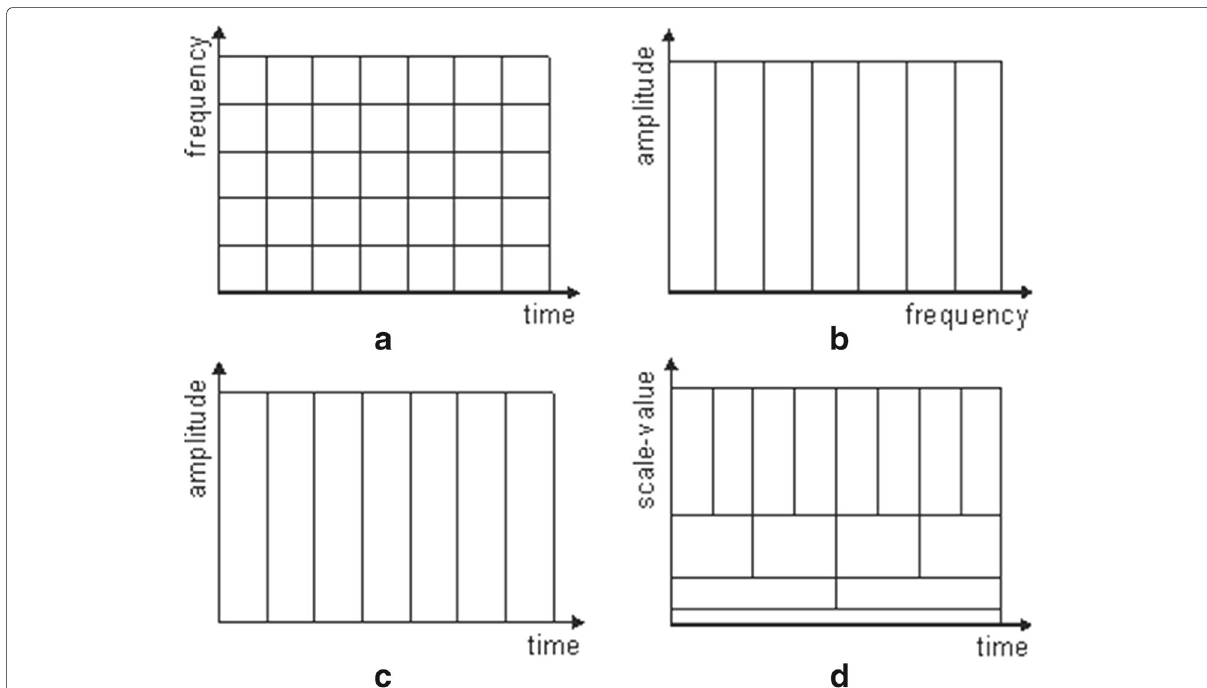
Fig. 4 Signal analysis in time, frequency, and time-frequency domain. a Signal/time domain. b Frequency/spectral domain. c Time and spectral domain (Gabor transform). d Time and spectral domain (wavelet